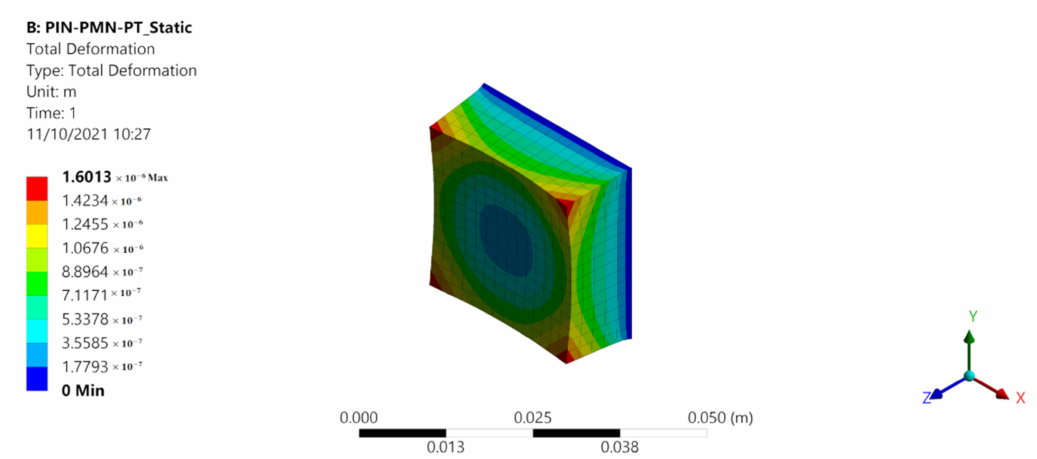
Figure 6. PIN24%-PMN-PT plate static analysis result using Method 1.